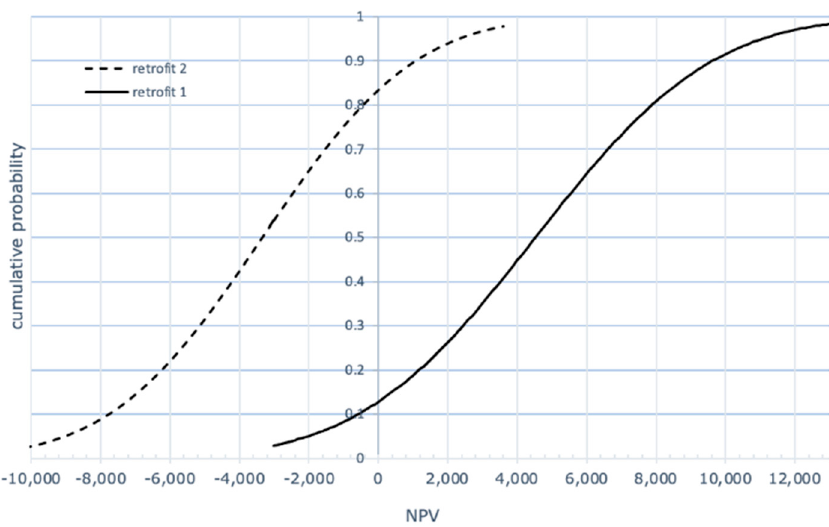
Figure 6. NPV cumulative probability distributions of Retrofits 1 and